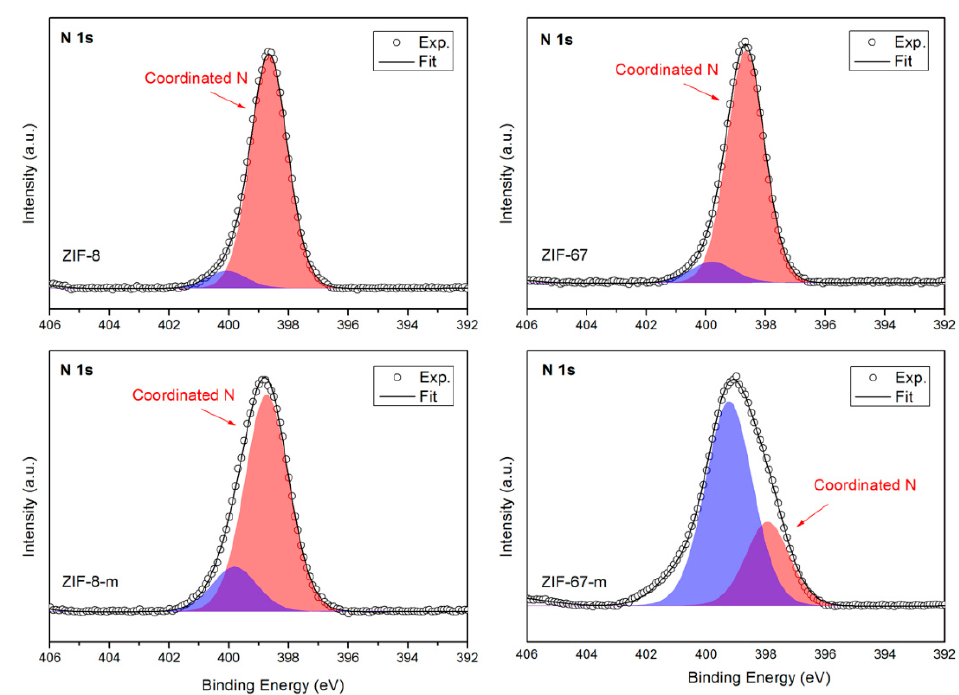
Figure 4. XPS spectra of the four catalysts.